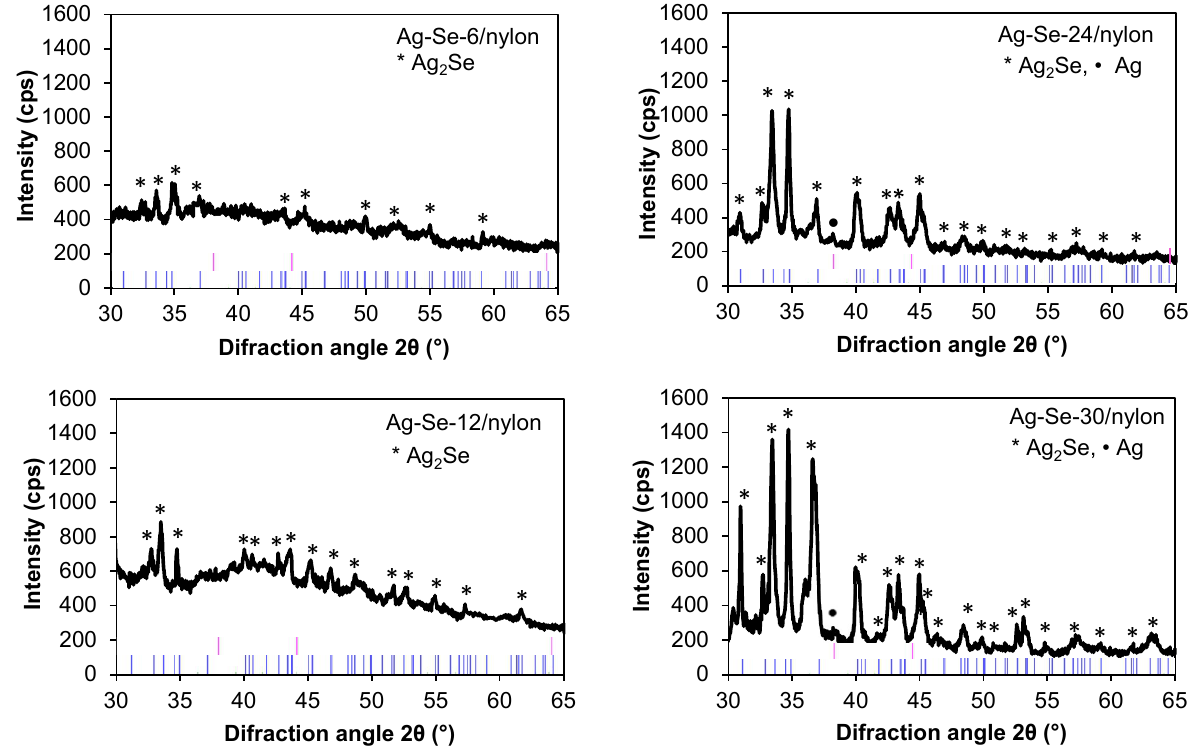
Figure 4. XRD patterns of Ag–Se films on the nylon surface. The black lines are the experimental patterns, and the pink and blue lines label the peaks from Ag (04-003-1472 (Calc., Intensity: 36.0%)) and Ag 2 Se (01-071-2410 (Calc., Intensity: 91.0%)), respectively. The Ag–Se-6/nylon nanocomposite showed diffraction peaks corresponding to the orthorhombic naumannite phase of Ag 2 Se (JCPDS # 01-071-2410, λ = 0.15406 nm). As ob- served from the pattern, the predominant (121) peak of the orthorhombic system represents a preferred orientation along this plane. The identified peak positions coincide well with the ones reported in literature for Ag 2 Se nanowires [5] and nanoparticles [30]. With a further increase in the selenium deposition time (Figure 4 Ag–Se-12/nylon sample), the intensity of the reflection (112) line increased, whereas the number of new peaks corresponding to the silver selenide phase rose. The diffractogram of the Ag–Se-24/nylon nanocomposite showed two sharp lines of nearly equal intensity along (112) and (121) planes,